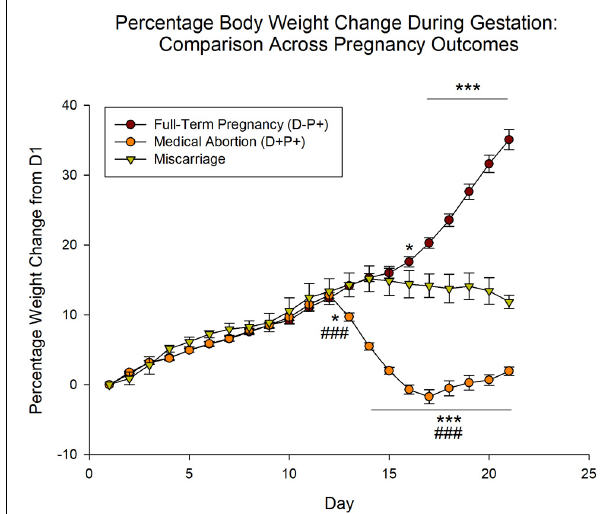
FIGURE 2 | Percentage rat body weight change during gestation period relative to Day 1 (D1) across pregnancy outcomes. Unlike rats undergoing pregnancy termination, which displayed a significant weight loss, the body weight of rats that naturally miscarried did not decrease significantly, but stabilized following the miscarriage. n = 19–20 rats/group (D+P+ and D − P+); n = 5 rats (miscarriage group). ∗ p < 0.05, ∗∗∗ p < 0.001 (Relative to Miscarriage Group); ### p < 0.001 (Relative to D − P+). Data is expressed as mean ± SEM.